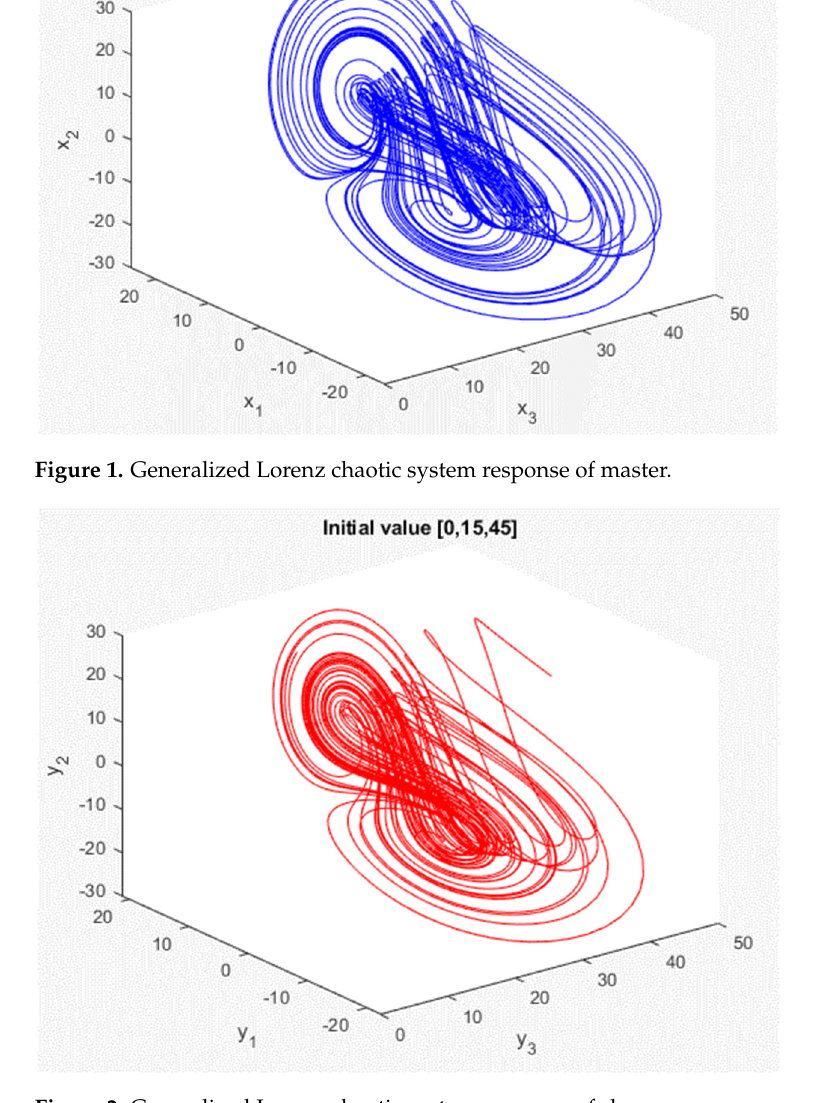
Figure 2. Generalized Lorenz chaotic system response of slave.